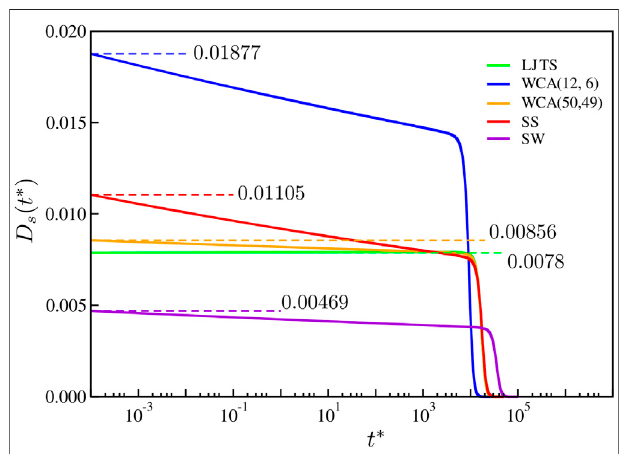
FIGURE 5 | Projected surface diffusion coef fi cient D s ( t ) as a function of the time for the interacting particles with potentials given in Figure 1 . The dashed lines represent the reference value D 0 in a planar